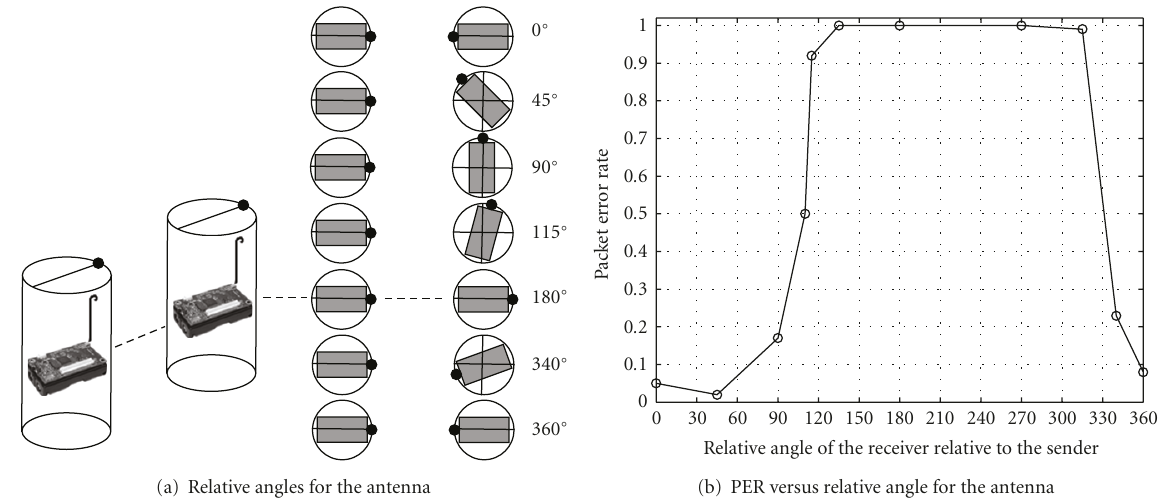
Figure 6: The scheme used to test the e ff ects of the antenna orientation in the wireless underground communication